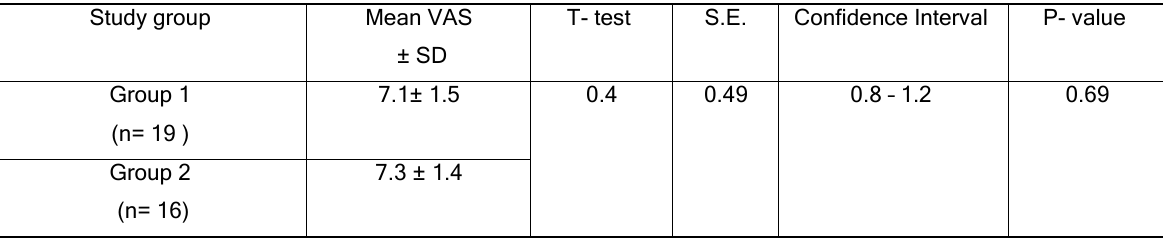
Table (3): A comparison between study groups in current study regarding VAS after 3 months of operation.